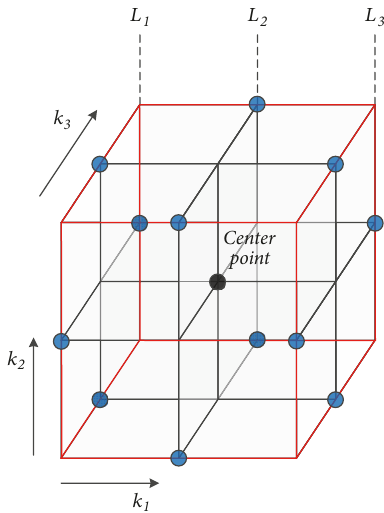
Figure 5: Graphical representation of Box-Behnken experimental design for 𝑘 = 3 .